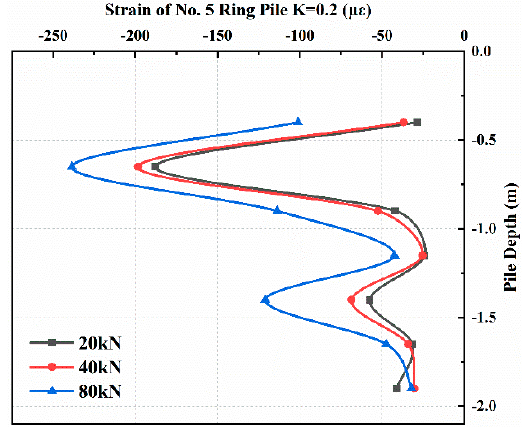
Figure 15. Pile strain of Ring Pile No. 5.